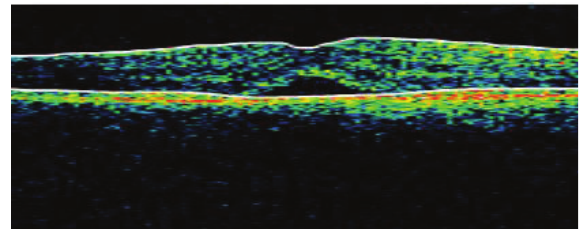
Figure 3: OCT image which shows the improvement of the serous macular detachment in the right eye after palliative